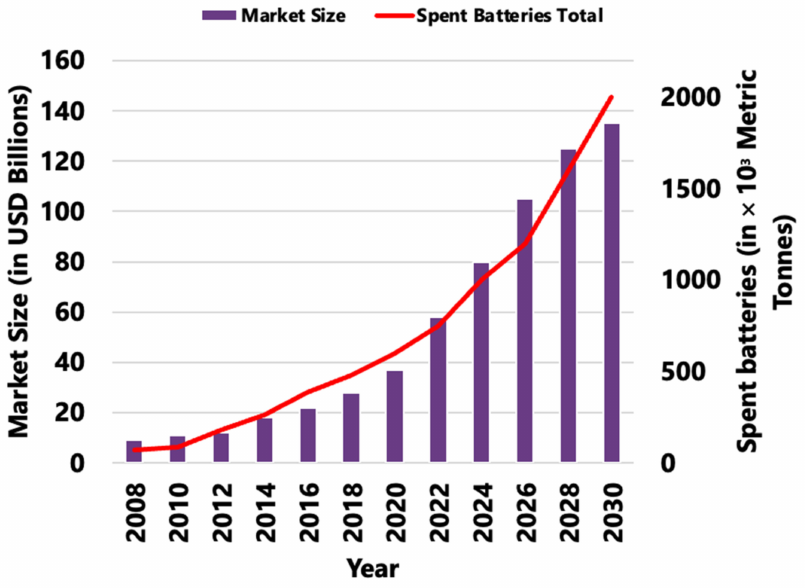
Figure 3. Global market size and total battery spent estimation of Li-ion batteries over the years (Data derived from refs. [1,2,23]).